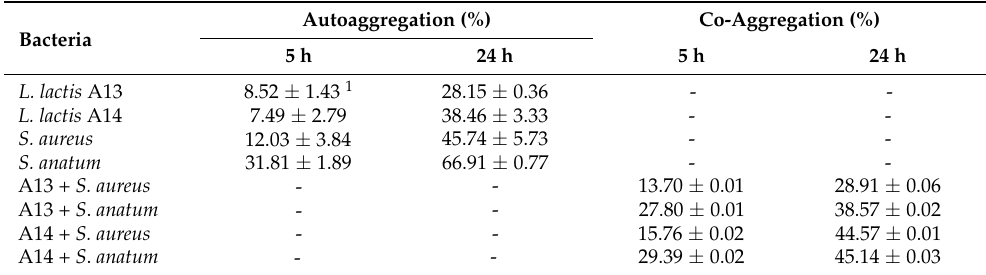
Table 6. Autoaggregation and co-aggregation abilities of the L. lactis A13 and A14 isolates.